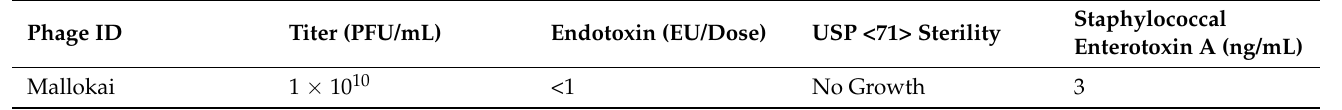
Table 1. Titer, endotoxin, sterility and exotoxin levels of the bacteriophage used in this case. Phage ID Titer (PFU/mL) Endotoxin (EU/Dose) USP <71> Sterility